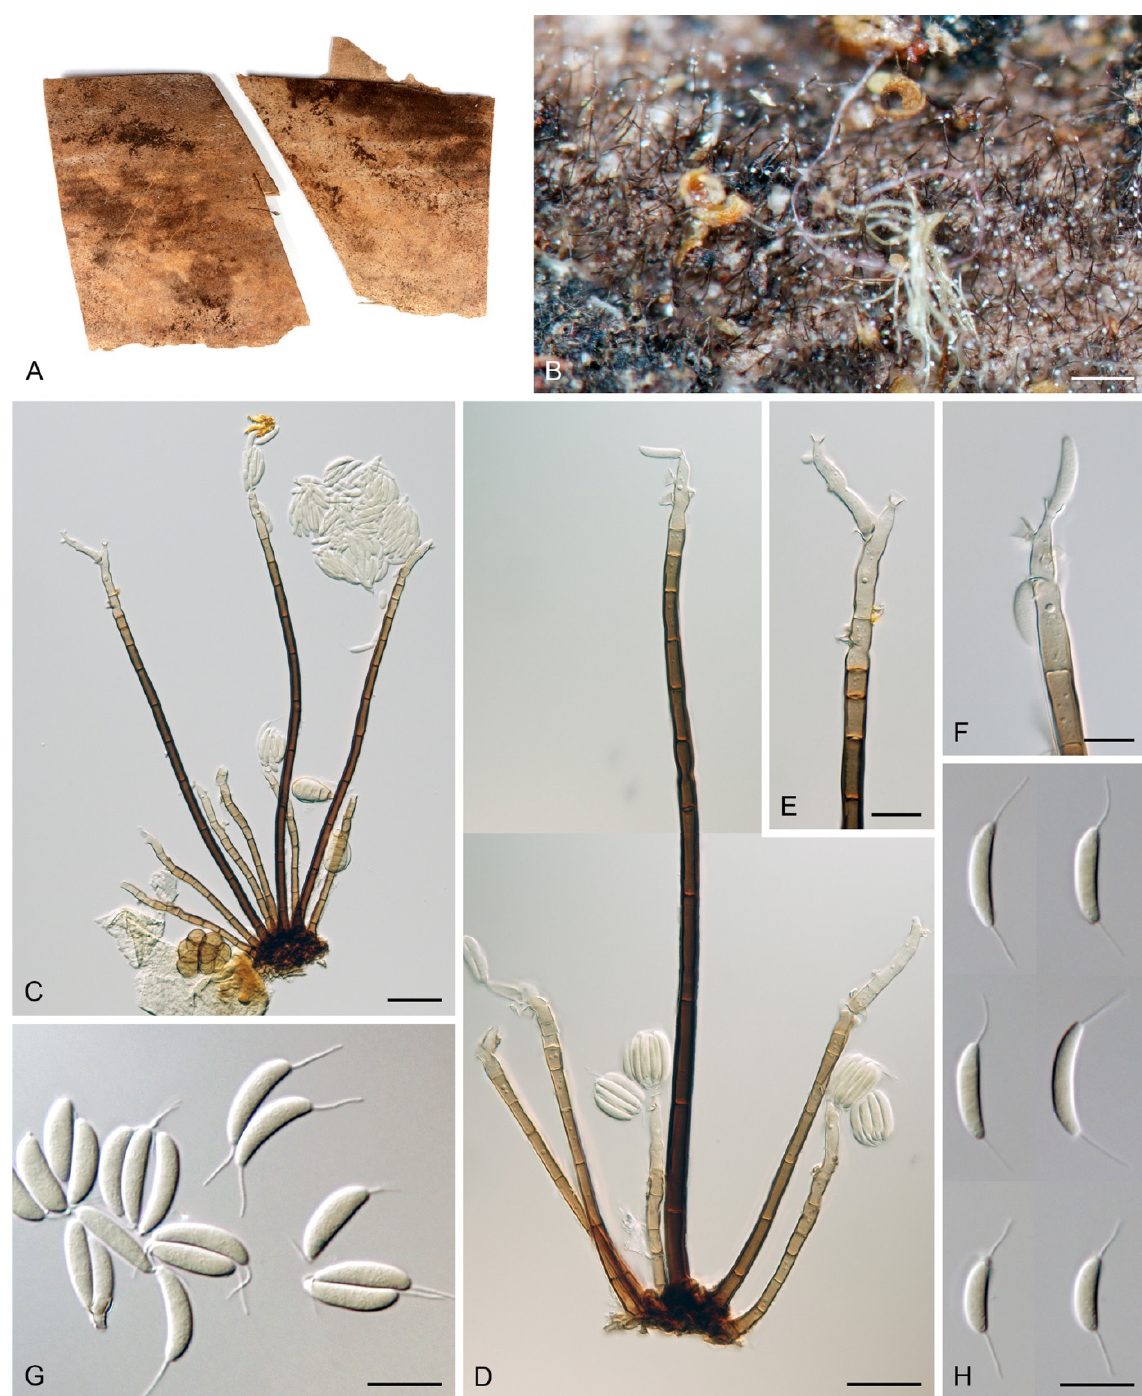
Figure 15. Codinaea fertilis (DAOM 93548c isotype). ( A ) Substrate with colonies ( B ) colony on a dead leaf ( C , D ) conidiophores ( E , F ) apices of setae with phialidic apertures ( G , H ) conidia. Images: ( A – H ) from nature. Scale bars: ( B ) 500 μ m; ( C ) 25 μ m; ( D ) 20 μ m; ( E – H ) 10 μ m.